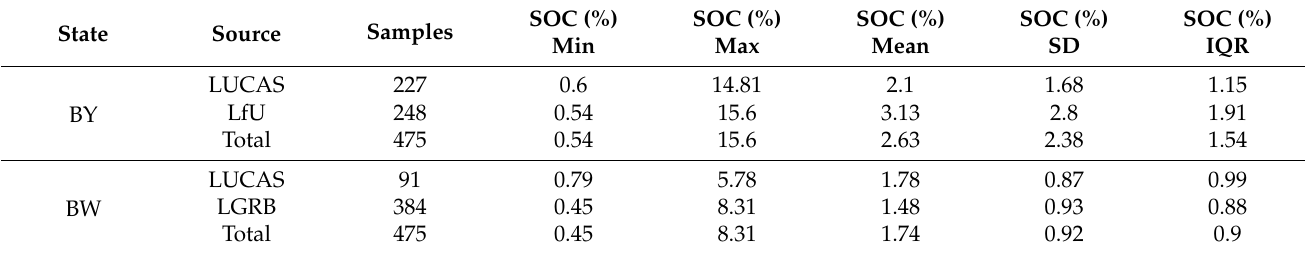
Table 2. Summary statistics of SOC measurements for each data source and both